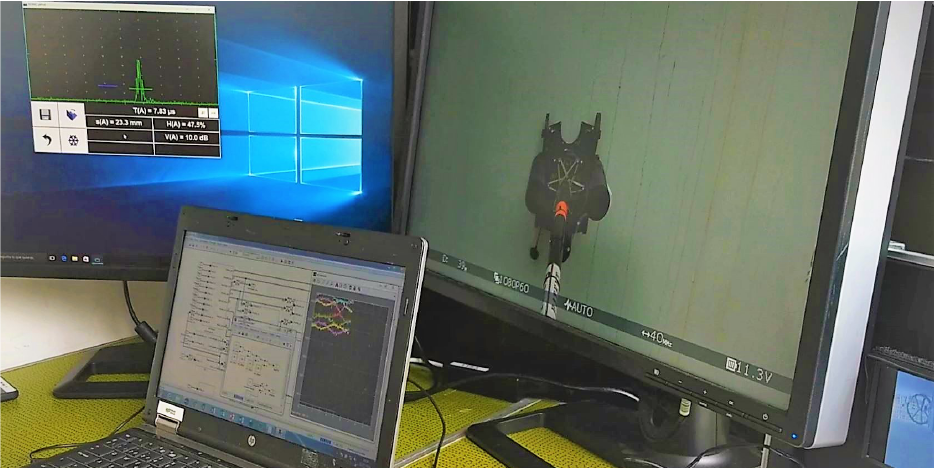
Figure 7. Main three screens visualized by the inspector during operation. On the right screen an onboard camera shows the end-effect and the surface under inspection. The screen on the left is used to manage and visualize the inspection sensors: an ultrasound measurement during this flight experiment is shown. The laptop shows the telemetry and status of